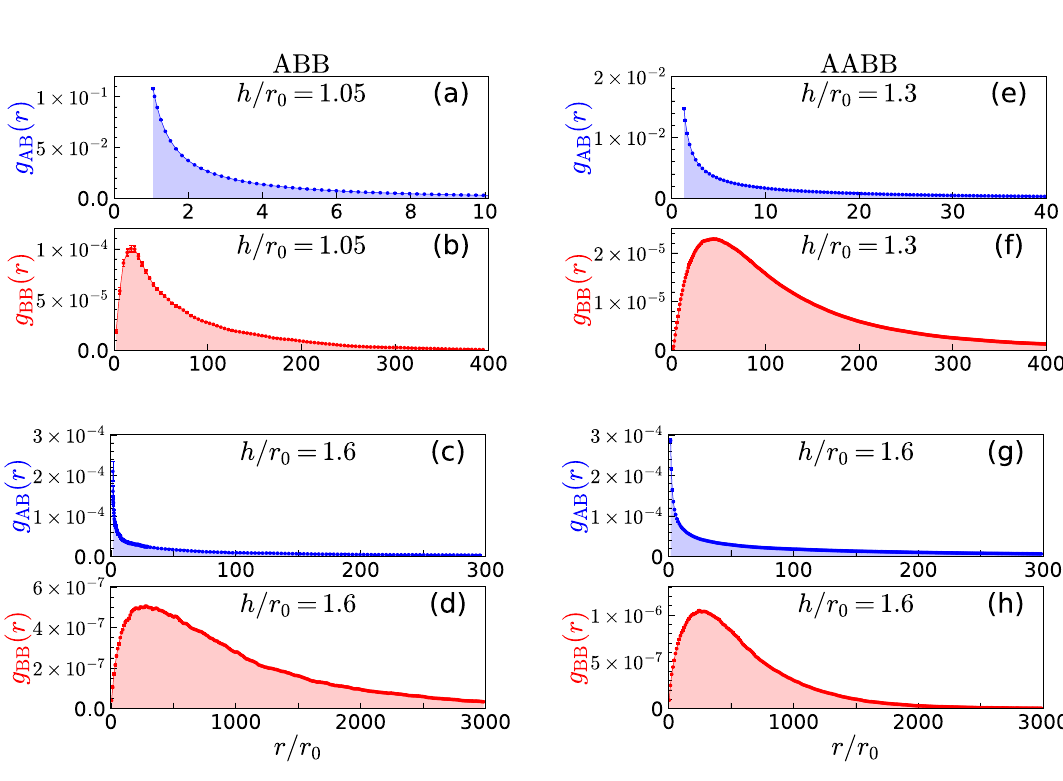
1.05 , 1.3 and 1.6. Notice the =